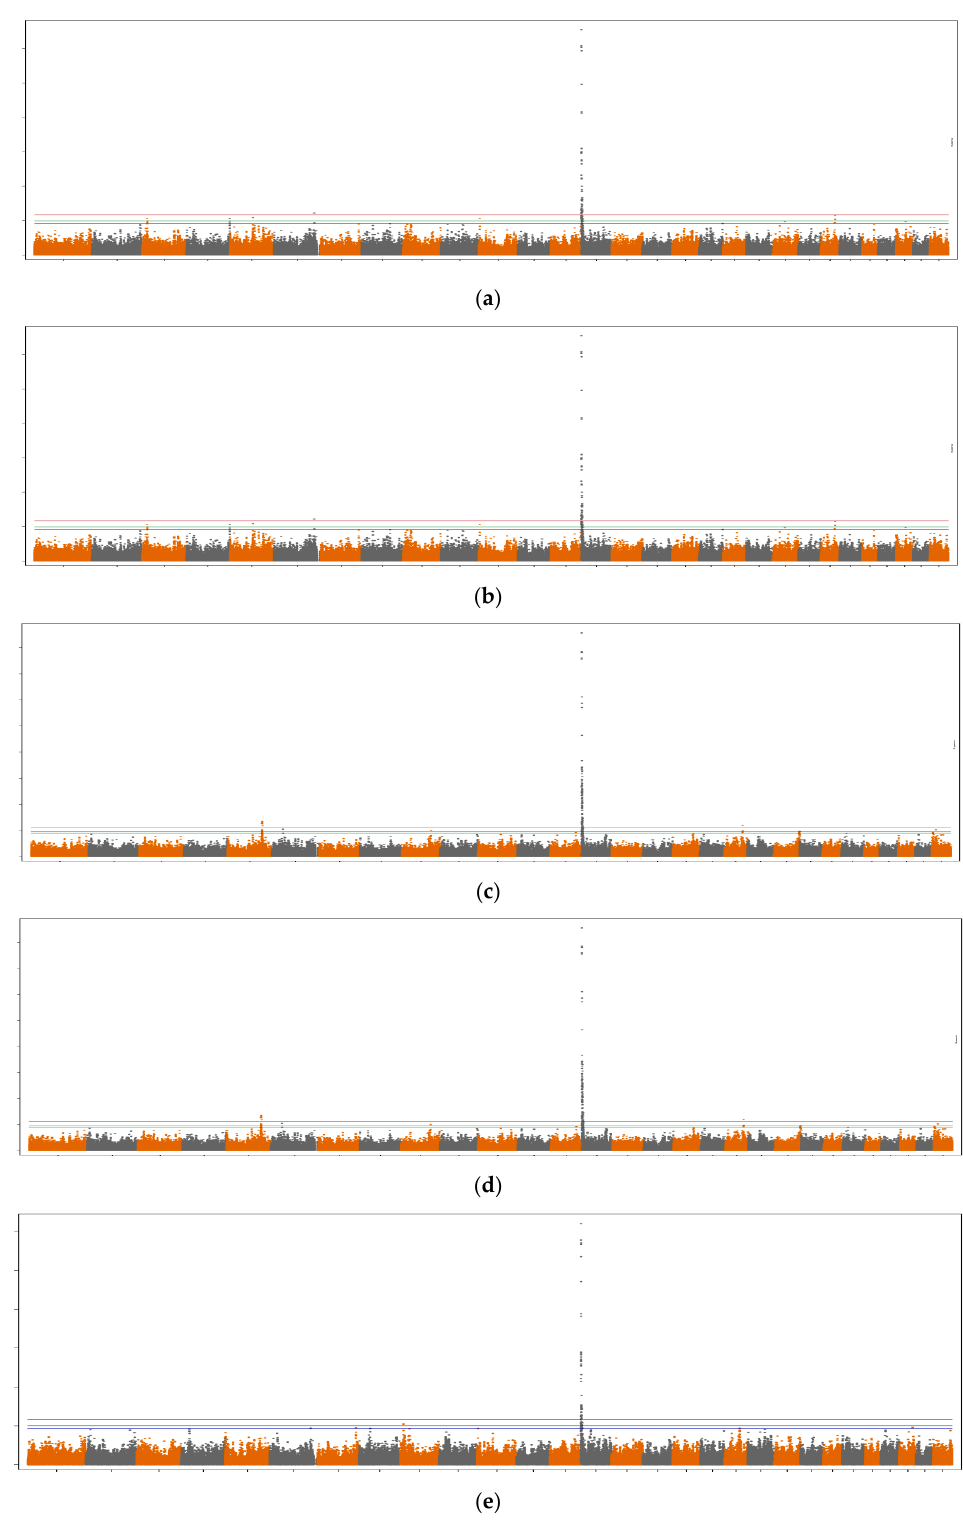
Figure 1. Manhattan plots for the different fatty acid groups [i.e., long-chain ( a ), medium-chain ( b ), short-chain ( c ), saturated ( d ), and unsaturated ( e ) fatty acids], when the DGAT1 gene was not fitted as a covariate in the statistical model. Genome-wide plots have the -log10 (I-values) in the y-axis and the chromosome number in the x-axis. Lines represent chromosome-wise FDR thresholds of 10% (blue), 5% (green), and 1%